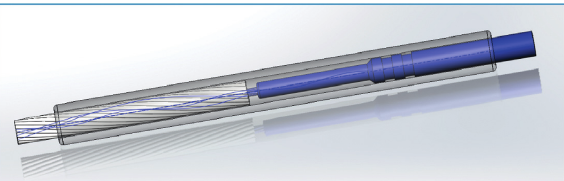
Figure 5: The 3D simulation model of the strain clamp-conductor system.